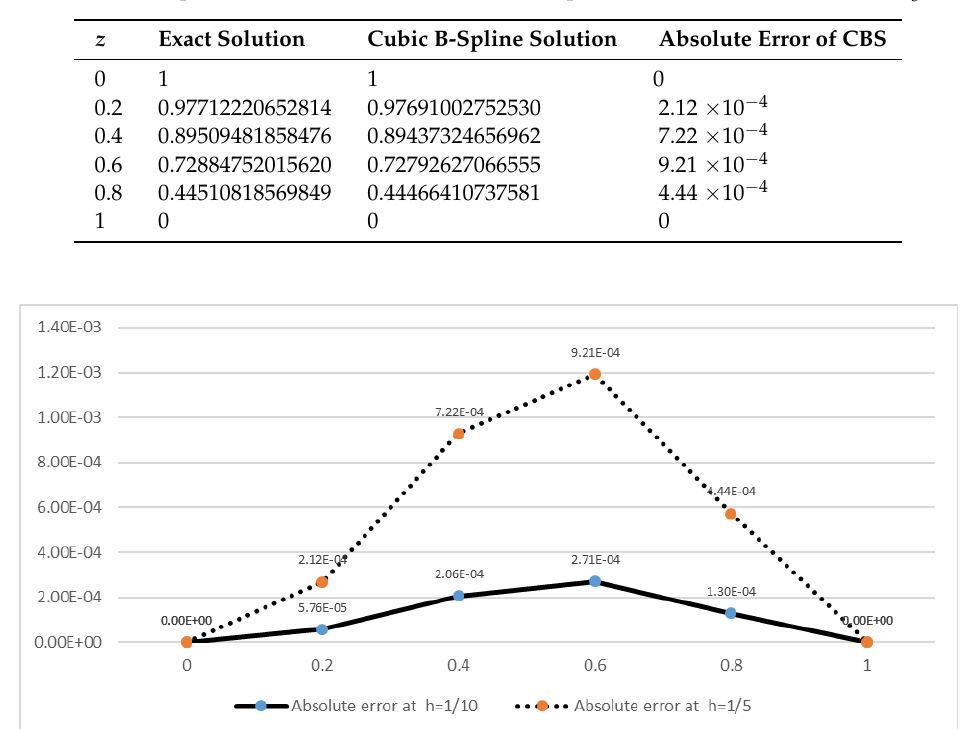
Table 3. Comparison of exact solution and Cubic B-spline solution of Problem 1 at h = 1